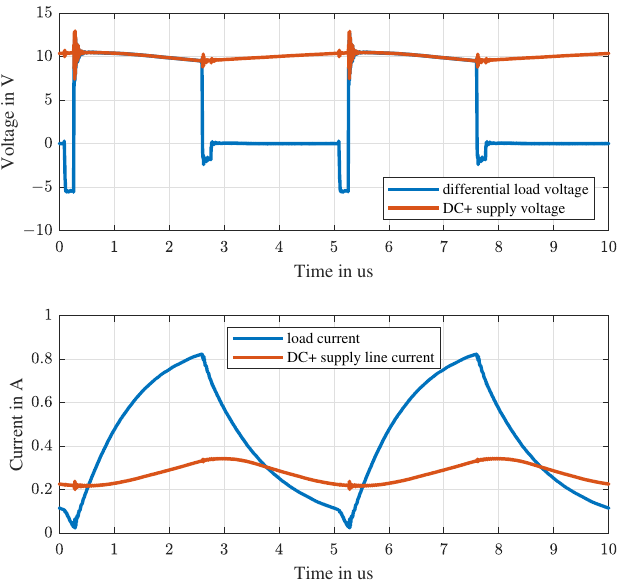
Figure 4. Time domain signals captured with an oscilloscope while the DUT was supplied with 10 V. The differential voltage at the load is measured between DC+ and the switched node.